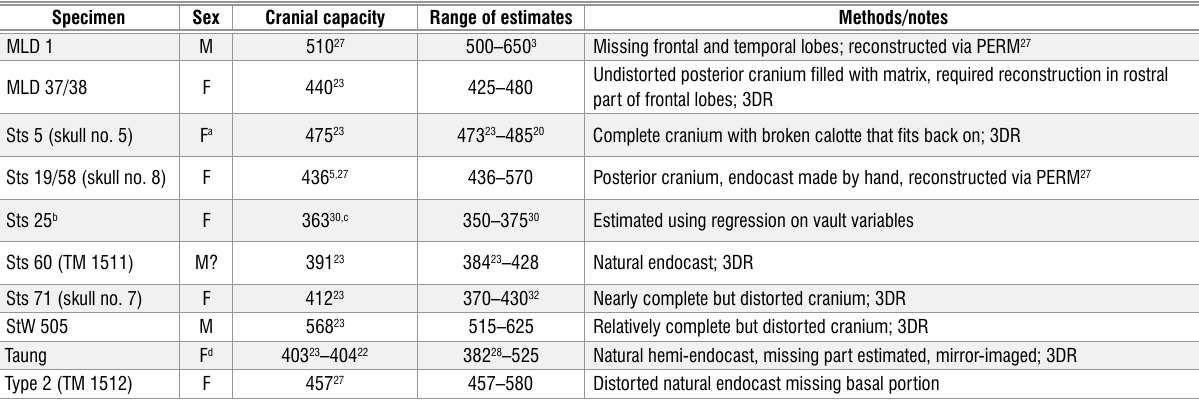
Cranial capacity values for Australopithecus africanus specimens. More information about ranges of estimates can be found in references 23,30,34 . Sex attributions follow Grine 35 . 3DR = three-dimensional digital reconstruction, including correcting distortion and reconstructing broken